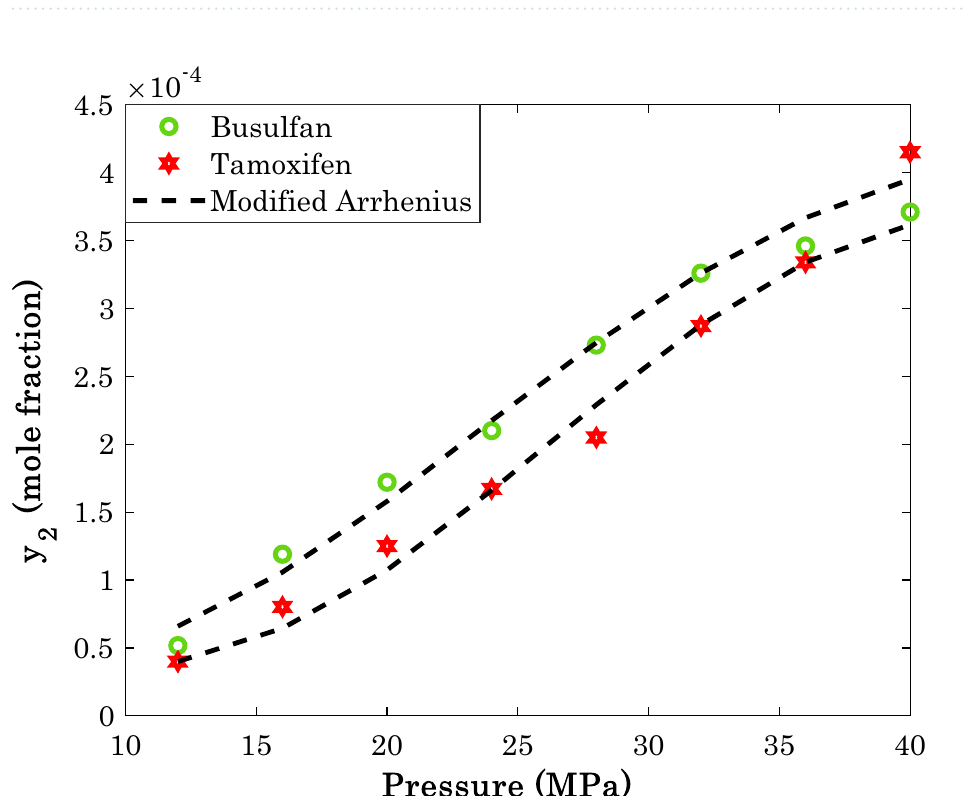
Figure 13. The highest amount of drug solubility in SCCO 2 at temperature = 318